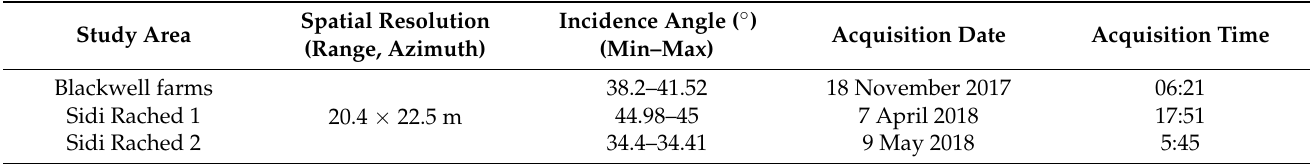
Table 4. Sentinel-1 acquisition details.